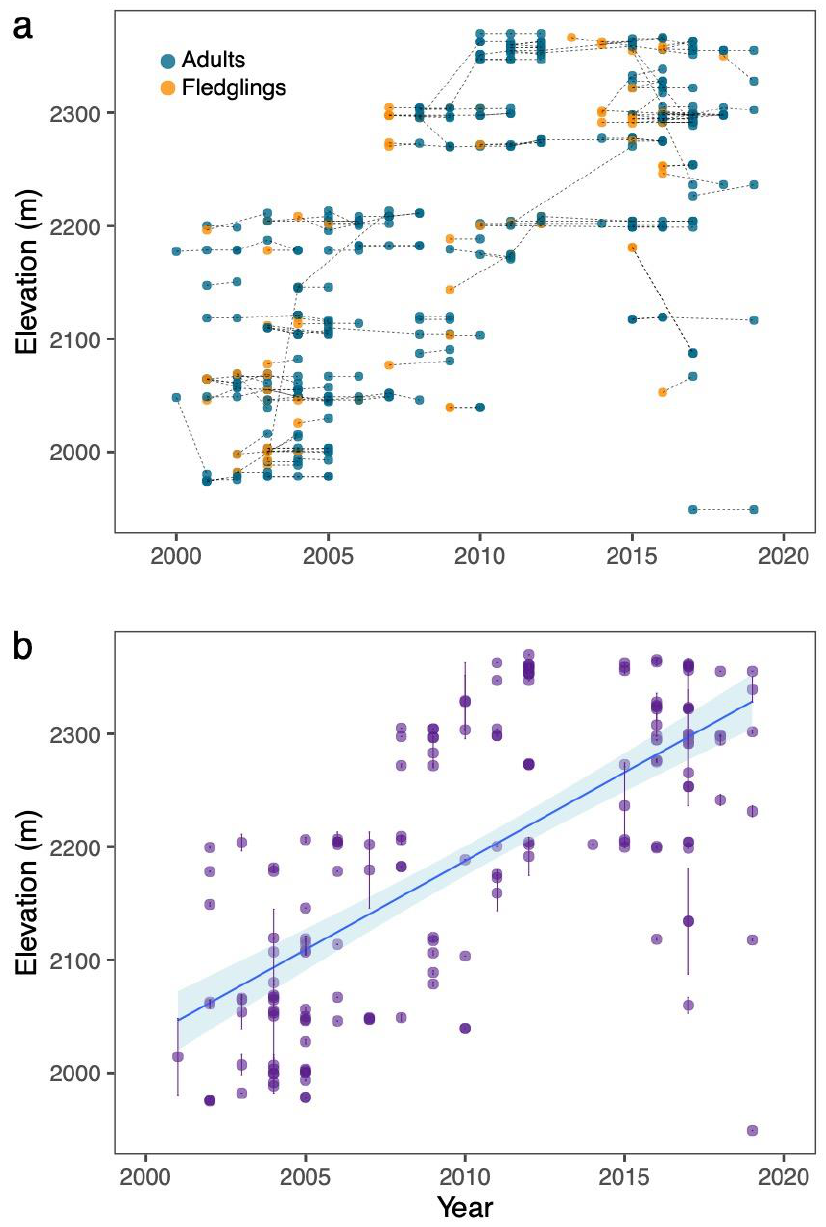
Figure 1. ( a ) The movement of nesting locations by elevation for individual birds year to year. Orange circles depict a bird that was banded as a nestling, and blue circles depict adults. Movements of an individual bird ( n = 182) are tracked by dotted lines. ( b ) Linear regression of nesting elevation over time for recaptured birds ( n = 182). Dots represent the mean (±SE) nesting elevation per bird. There was a significant positive relationship over time (LM: estimate = 15.69, SE ± 1.21, t = 12.93, p < 0.001, R 2 = 0.48). Area shaded blue is the 95% confidence interval.